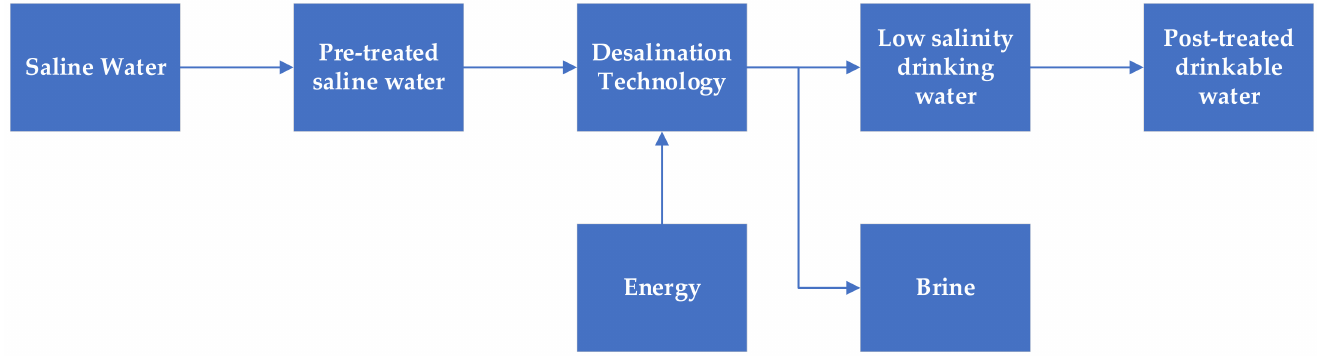
Figure 1. The desalination